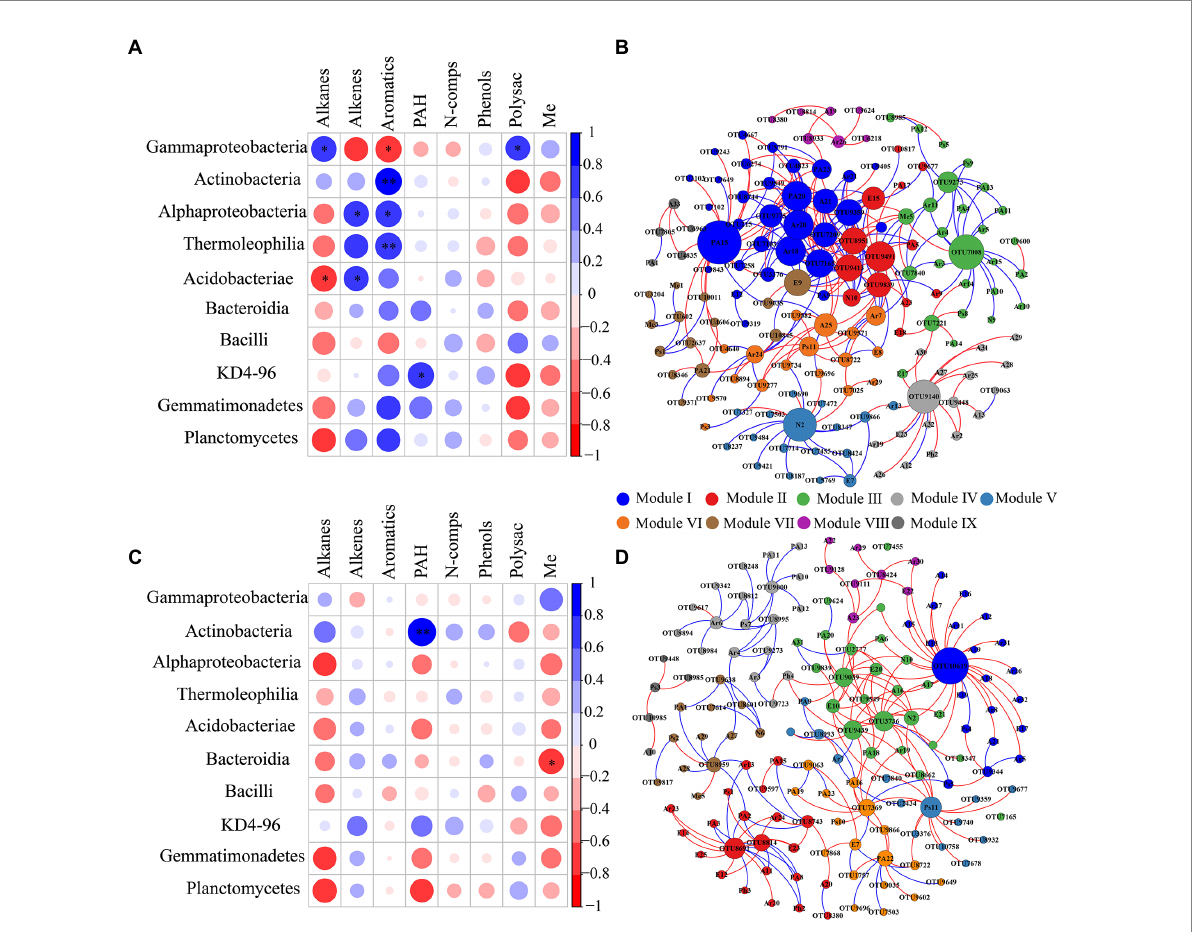
FIGURE 6 Spearman correlation analysis of the relative abundance of DOM chemical composition with the relative abundance of dominant bacterial class in (A) 0–10 cm; (C) 50–60 cm; *, **, *** indicate significant differences at p < 0.05, < 0.01, and < 0.001, respectively. The occurrence network between total DOM molecules and microbial OTUs based on Spearman correlation (| r | > 0.8, p < 0.001) in (B) 0–10 cm; (D) 50–60 cm. Positive and negative correlations are represented in blue and red lines, respectively. The size of each node is proportional to the number of connections. The color of the node indicates the module of the cluster. Abbreviations for DOM molecules are as in Supplementary Table